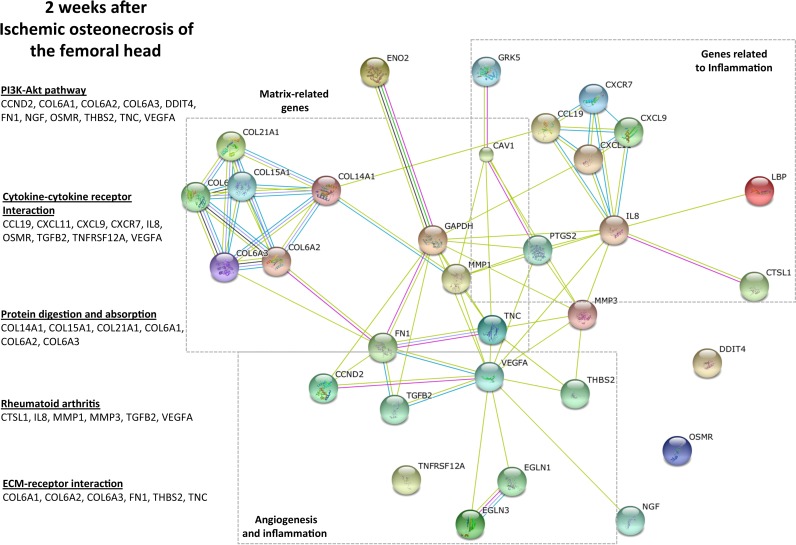
Angiogenesis, matrix remodeling and inflammation are the most significantly enriched functions in the immature articular cartilage at 2 weeks following the induction of ONFH.The genes and the specific pathways that were significantly enriched (p<0.05, based on t-tests, Bonferroni, FDR) are listed. The STRING10 network diagram was used to indicate the closeness of relationship of different genes based on the functional roles in biological pathways. The clusters of genes indicating matrix-related functions (e.g. FN, TNC, MMP1, MMP3), angiogenesis (e.g. VEGF) and inflammation (e.g. IL8, OSMR) are shown. The nodes indicate individual genes and the connecting lines indicate the relationship. Shorter lines indicate closer relationship. The evidence plot utilizes multiple lines to indicate stronger evidence for the proximity in a functional relationship.